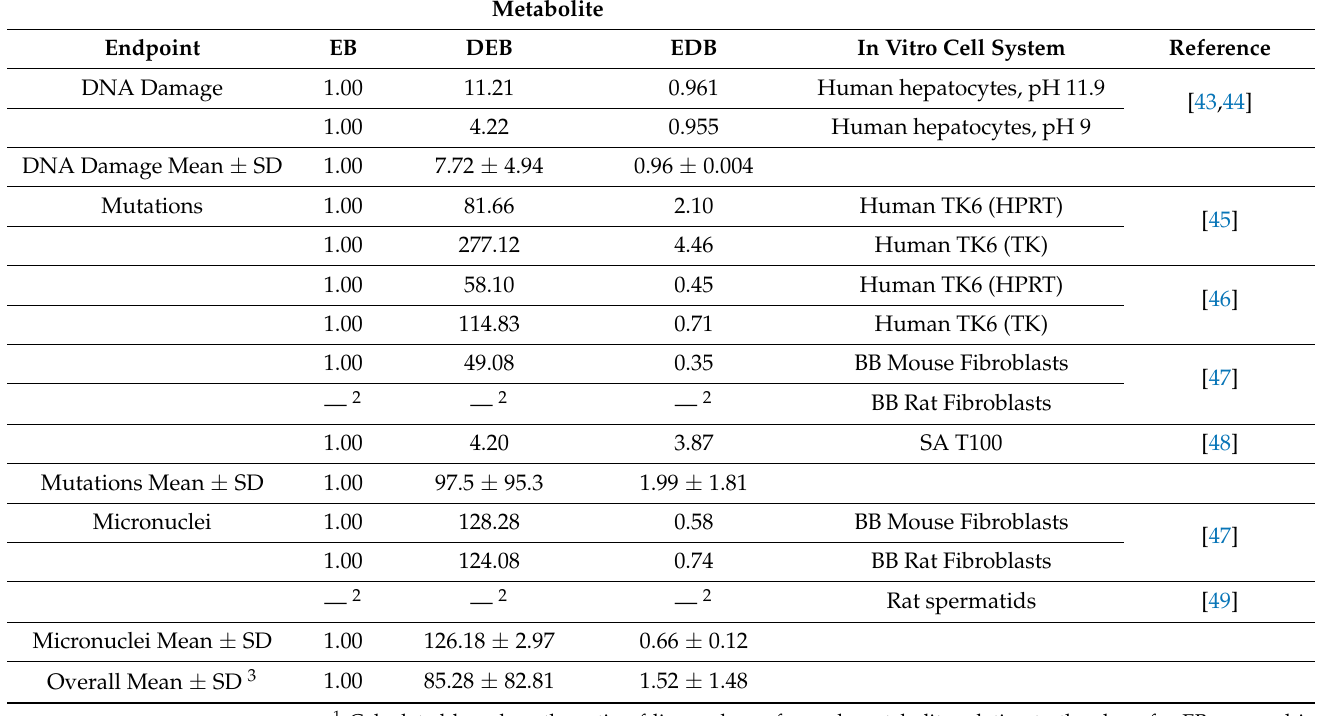
Table 5. Relative genotoxic potencies of BD metabolites in mammalian cells 1 . Metabolite